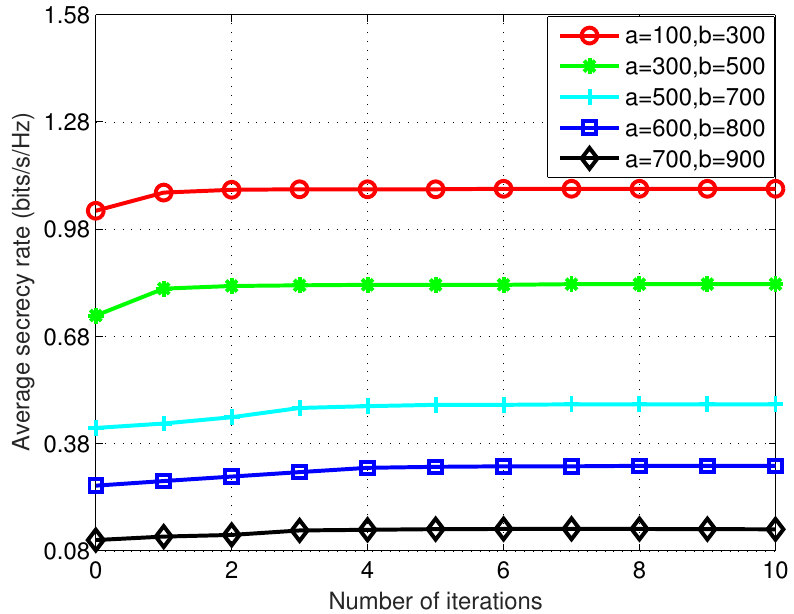
Figure 3. Average secrecy rate performance for different distribution boundaries of the eavesdropper location with maximum UAV speed v = 20 m/s and total flight time T = 80 s. The eavesdropper located further away from the destination is shown to be more favorable to the overall average secrecy rate